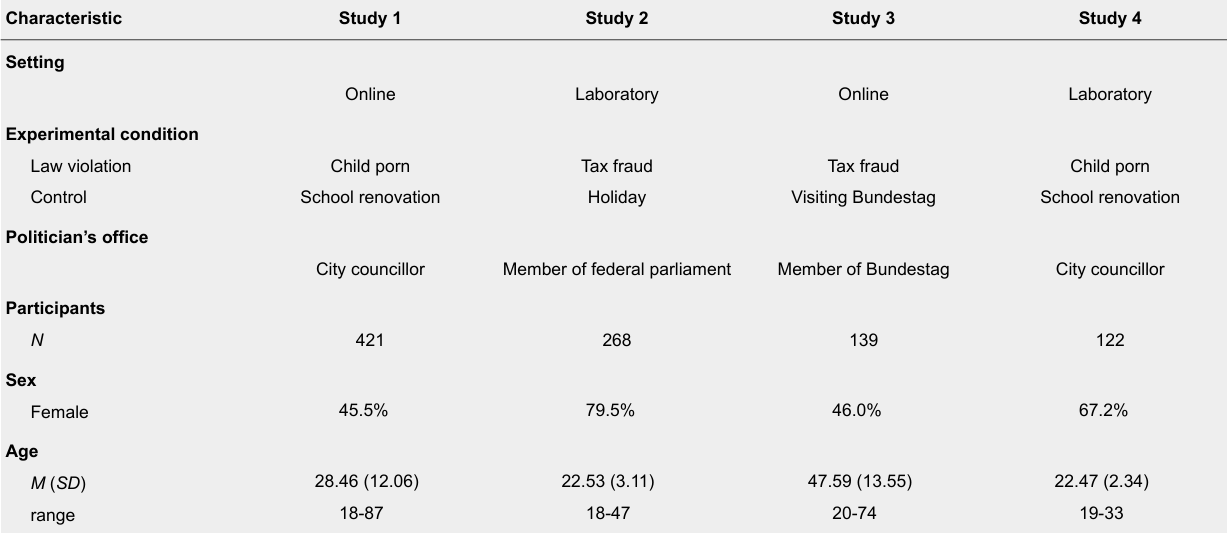
Demographic Data for Studies 1 to 4